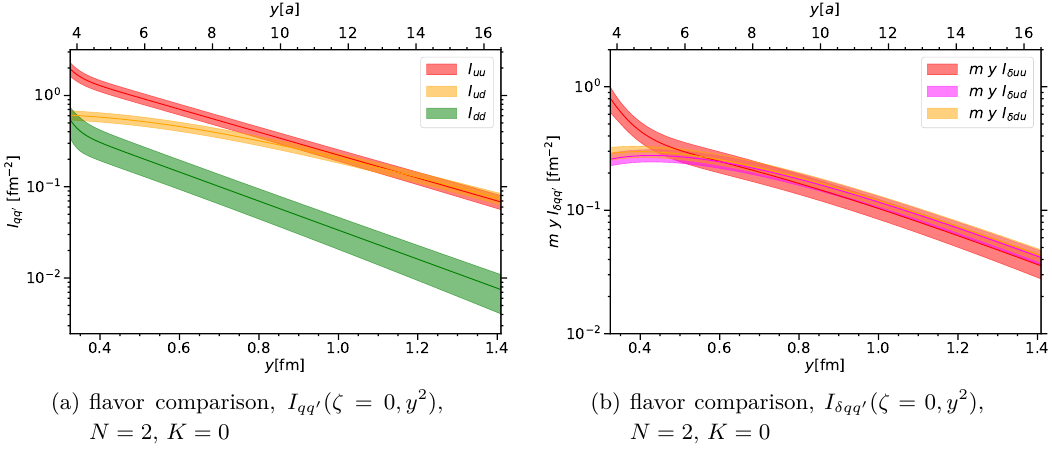
Figure 21 . Results for the Mellin moments I qq 0 (a) and I δqq 0 (b) obtained from fits with ( N, K ) = (2 , 0) . In each panel we compare contributions for different flavor combinations using a logarithmic scale on the vertical